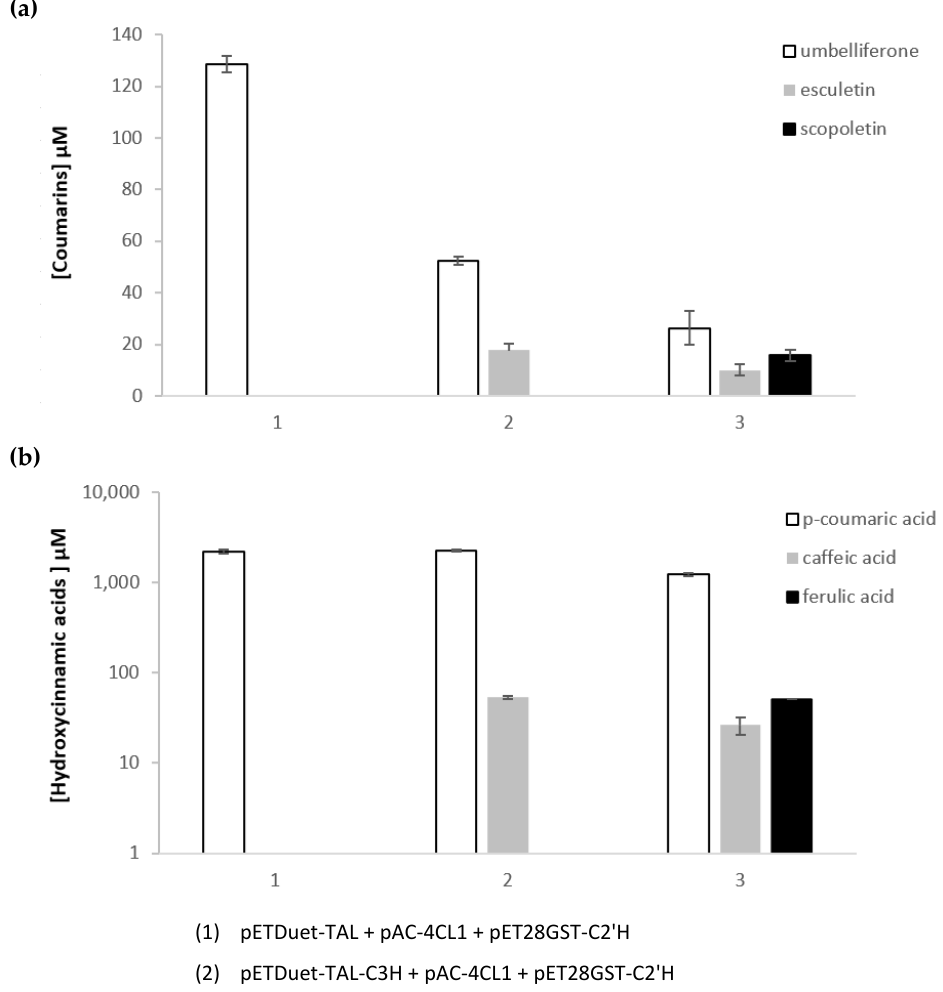
Figure 4. Coumarin production in Escherichia coli using tyrosine as precursor and different combinations of plasmids. Coumarins concentrations (a), hydroxycinammic acids concentrations (b). 4CL1: 4-coumarate-CoA ligase 1; C2 ′ H: p -coumaroyl-CoA 2 ′ -hydroxylase; C3H: 4-coumarate 3- hydroxylase; CCoAOMT: caffeoyl-CoA 3-O-methyltransferase; TAL: tyrosine ammonia lyase.